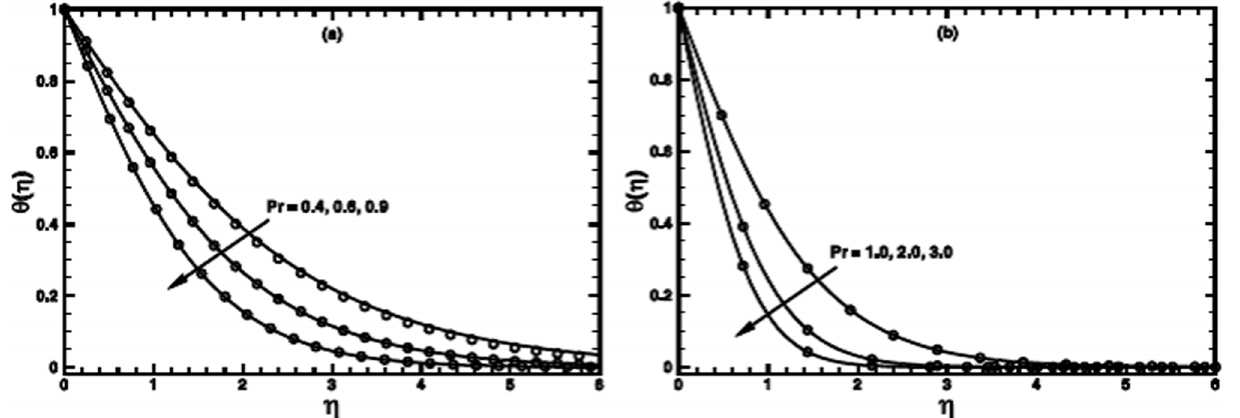
Figure 11. A comparison of the exact and numerical results (solid line numerical results and open circles exact results) in the PST case when n ~ 1 , s ~ 1 and A ~ 1 are fixed.